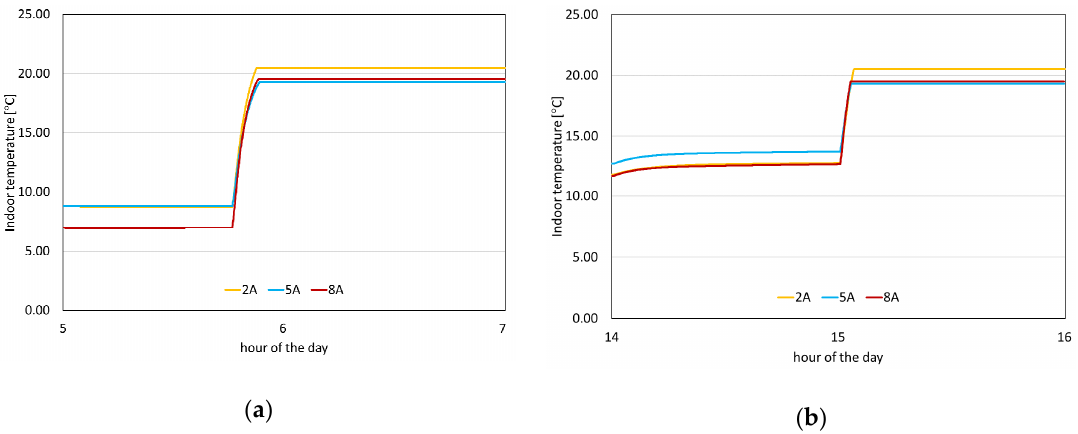
Figure 8. Simulated indoor temperature trends of apartments 2A, 5A and 8A during the warm-up time of a representative day: ( a ) from 5:00 a.m. to 7:00 a.m.; ( b ) from 14:00 p.m.to 16:00 p.m.